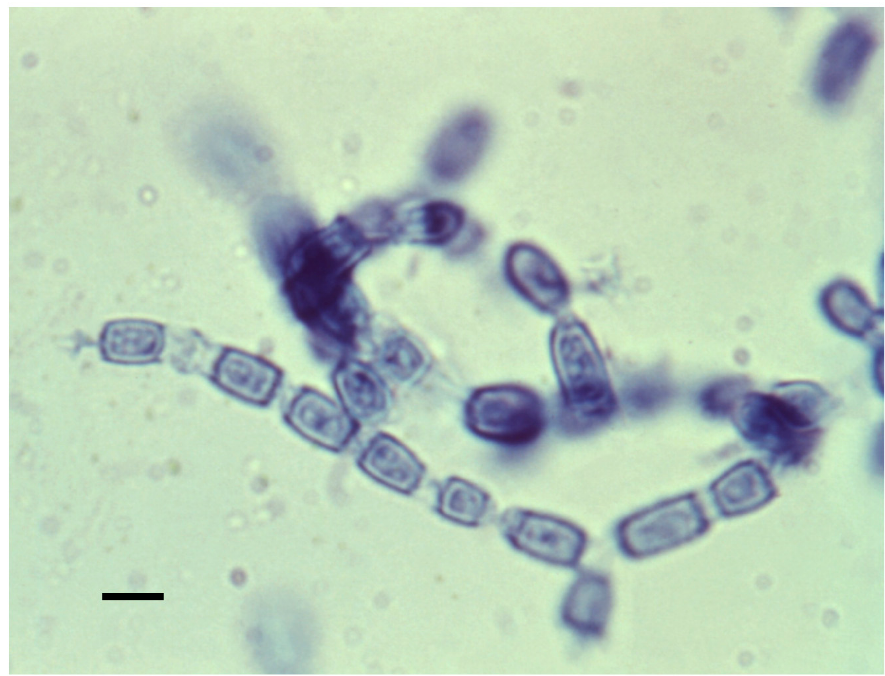
Figure 5. Arthroconidia within mycelia. Every alternate cell has degenerated. The bar is 5 µ M. The figure is from the Centers for Disease Control and Prevention. (https://phil.cdc.gov/Details.aspx? pid=15780) (accessed on 10 August 2022).